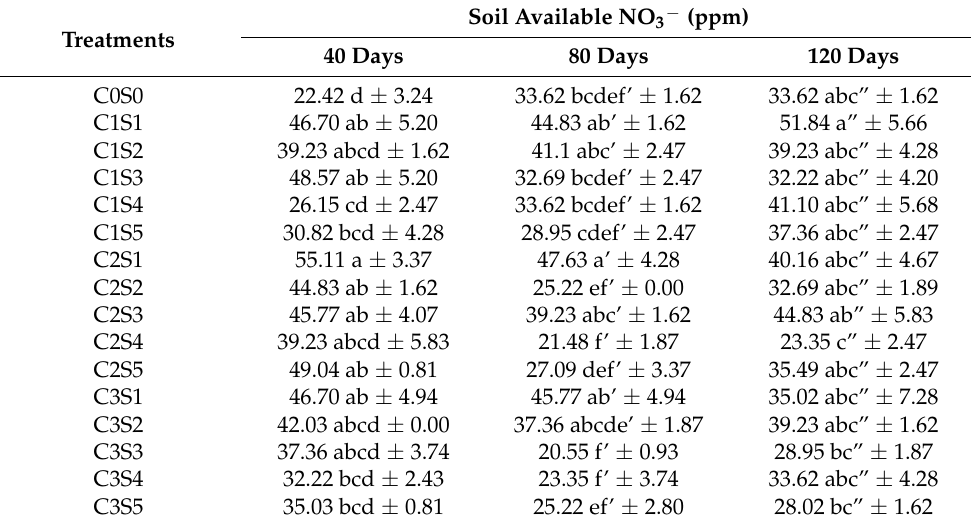
Table 9. Mean soil available nitrate in relation to combined use of Calciprill and sodium silicate at forty, eighty, and one hundred and twenty days